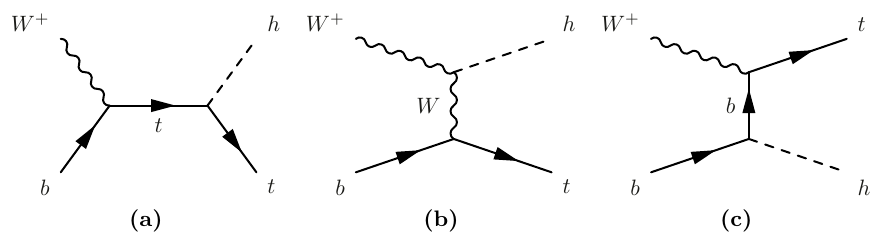
Figure 12. SM diagrams for the bW